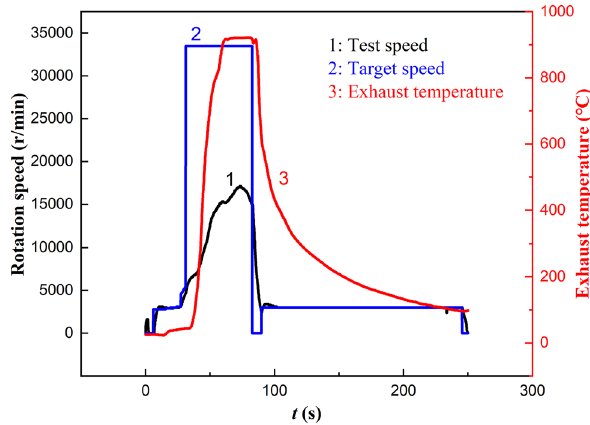
Figure 6: Test and target speeds and the exhaust temperature during the fi rst testing of SWS - SiC/SiC turbine